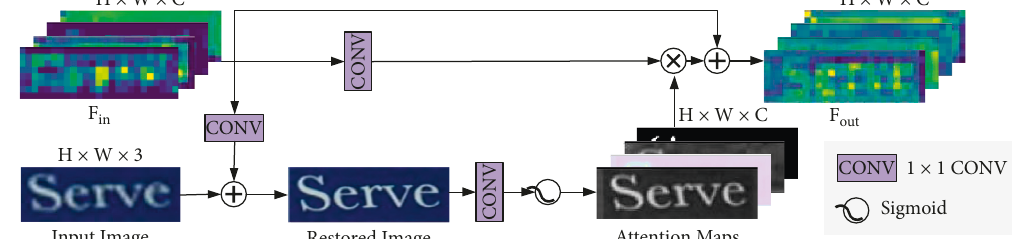
Figure 3: Structure of the SAM.